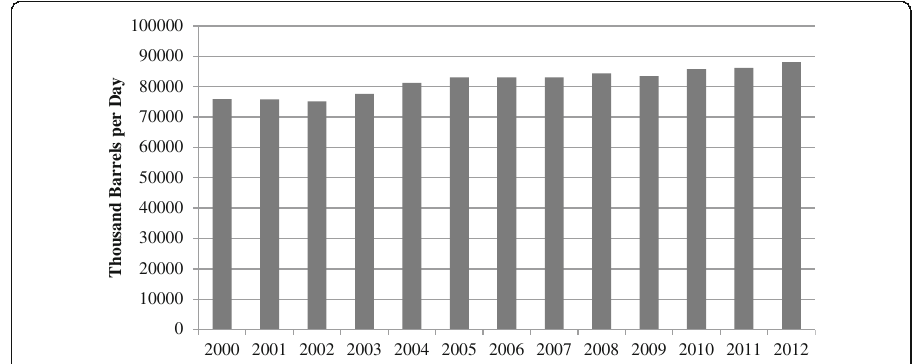
Fig. 7 Global crude oil production. Source: U.S. Energy Information Administration (EIA)